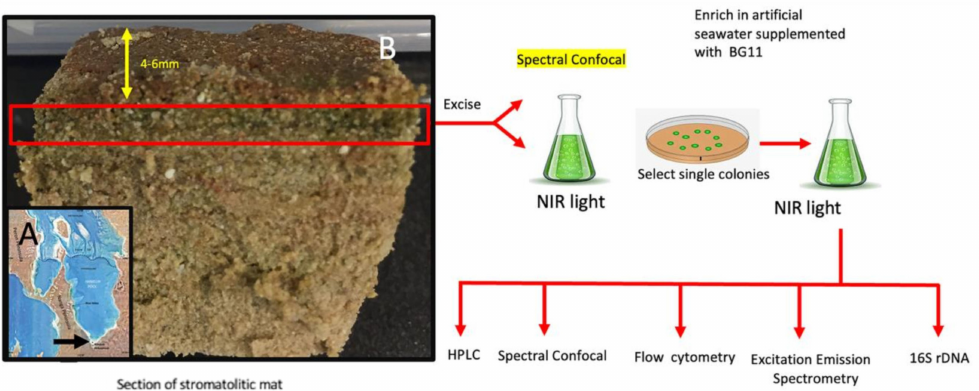
Figure 1. Sampling and enrichment: ( A ) Map showing the Hamelin Pool, with an arrow indicating the position of the sampling site at Nilemah. ( B ) Overview of sampling, culture enrichment and analysis